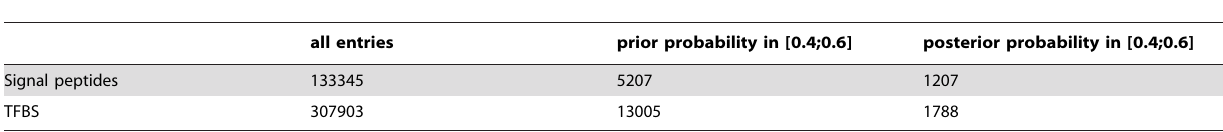
Table 2. The number of entries in the grey zone for both data sets.